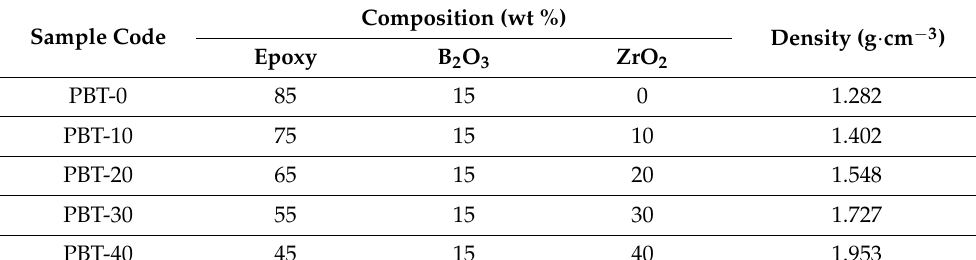
Table 1. The compositions of the prepared samples.